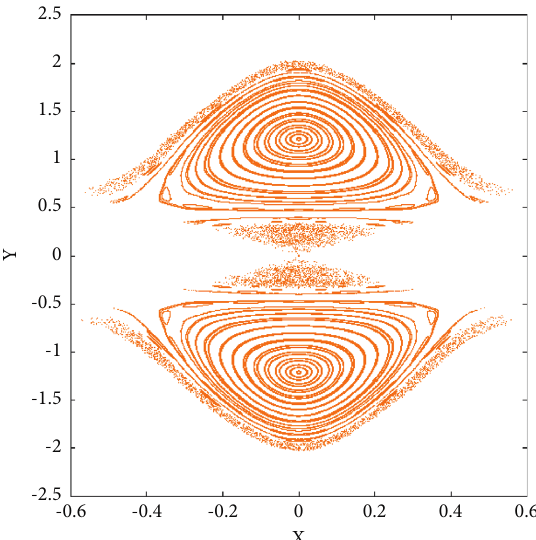
Figure 4: The Poincare section with crossing section.